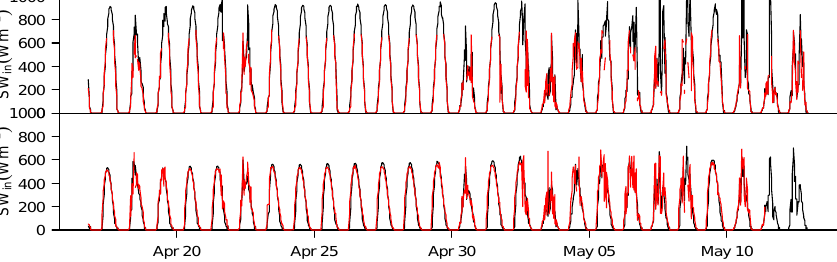
Figure 6. Modelled (black) and measured (red) incoming short-wave radiation at the two slope stations in spring 2003 (top panel: southwest- facing slope; bottom panel: northeast-facing slope). All the data above 710Wm − 2 are unavailable on the southwest-facing slope because the programmed maximum data-logger voltage range was exceeded.